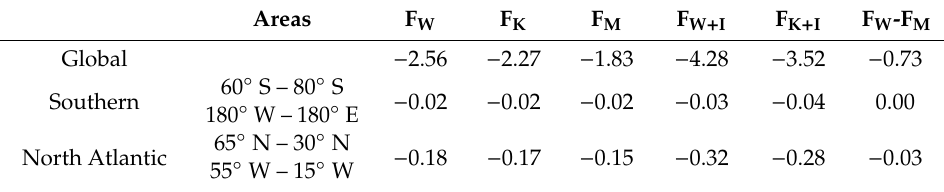
(latitude and longitude given) and di ff erent parameterizations from the SOCAT-based globally gridded Table 4. Annual mean ocean–atmosphere CO 2 fluxes (Gt C yr − 1 ) from the different regions (latitude dataset analysis from 1982 to 2018. The final column presents the di ff erences between the flux calculated and longitude given) and different parameterizations from the SOCAT-based globally gridded from Wanninkhof’s (F W ) and this study’s (F M ) parameterizations. dataset analysis from 1982 to 2018. The final column presents the differences between the flux calculated from Wanninkhof’s (F W ) and this study’s (F M ) parameterizations. Areas F W F K Global